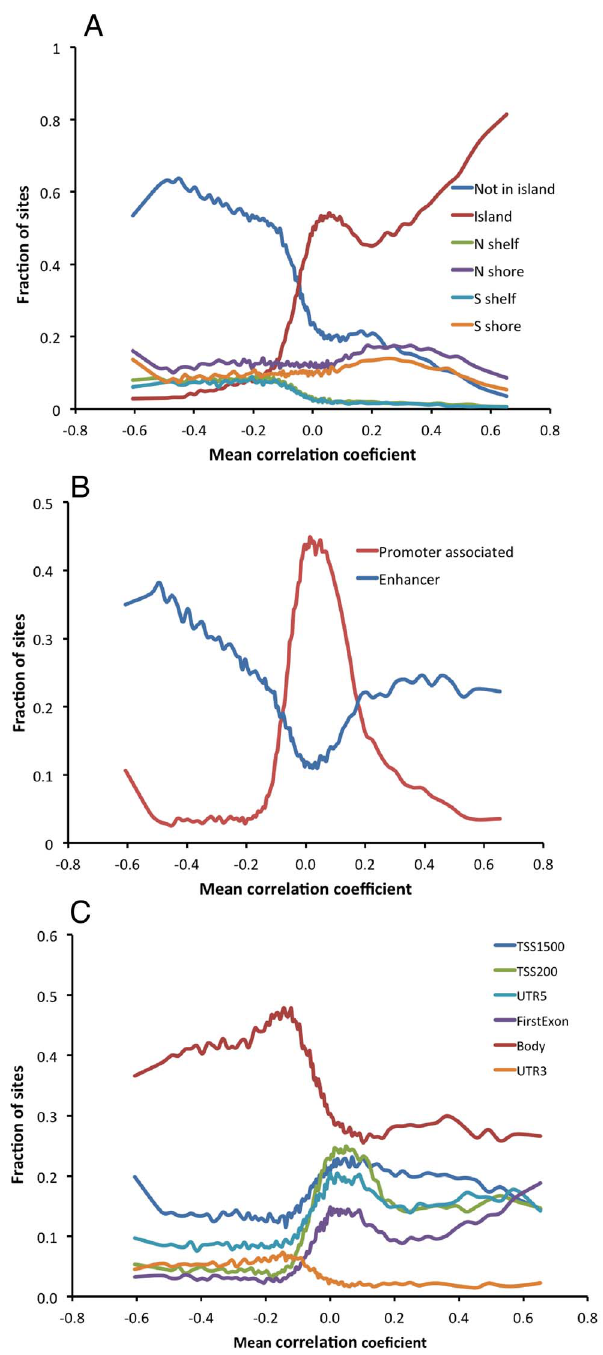
Figure 3. Location of CpG site depending on correlation between DNA methylation level and chronological age. Observations are ordered by the correlation coefficients and combined into 100 bins. The illustrations show the fraction of markers within each bin with a location in relation to, A) CGIs, island shores and islands shelves, B) Known promoter and enhancer regions, and C) Gene and transcription starting site. cerebral cortex neuron differentiation is over 30 times enriched for hypermethylated genes (Supporting information Table S3, and Figure S2). The genes that become hypomethylated with age do